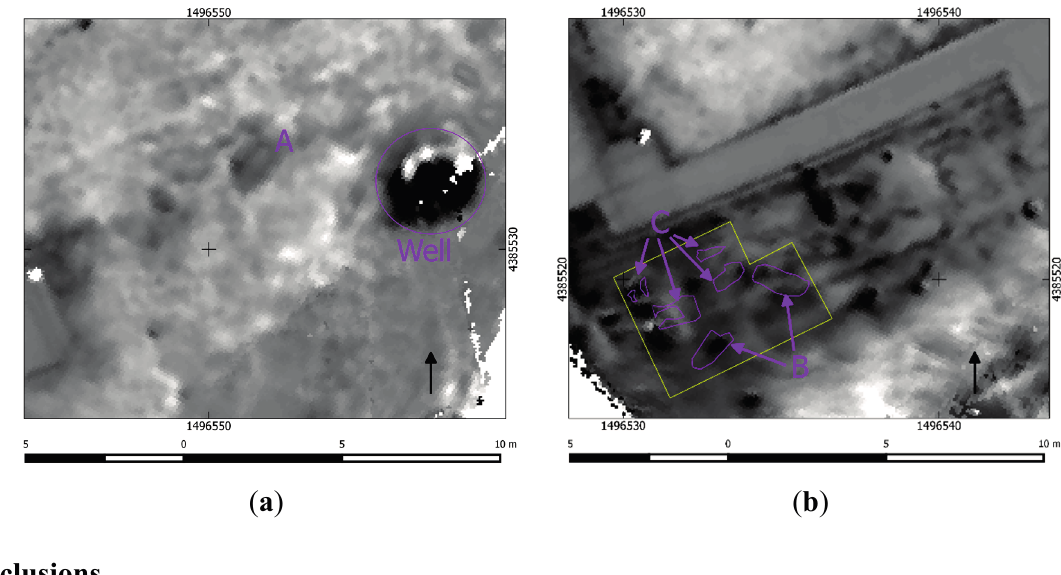
Figure 17. Details of the archaeological analysis of the map from Figure 16 (obtained by multiplying normalized intercept temperature by normalized NTG maps). ( a ) Detail of the thermal map with Thermal Pattern A in correspondence with the GPR anomaly indicated as A in Figure 12; ( b ) detail of thermal patterns superimposed by dug (after the survey) tombs (B and D), and in yellow, the border of the most recent digging